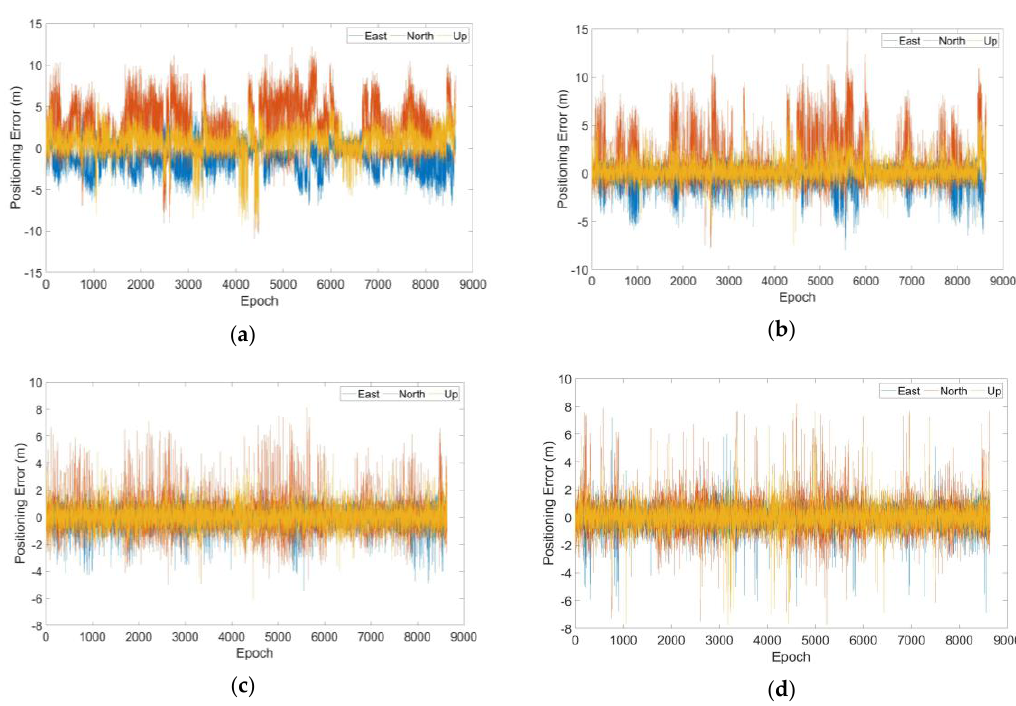
Figure 10. Positioning errors of four detectors for the worst combination in Case 2: ( a ) detector 1, ( b ) detector 2, ( c ) detector 3 and ( d ) detector 4.